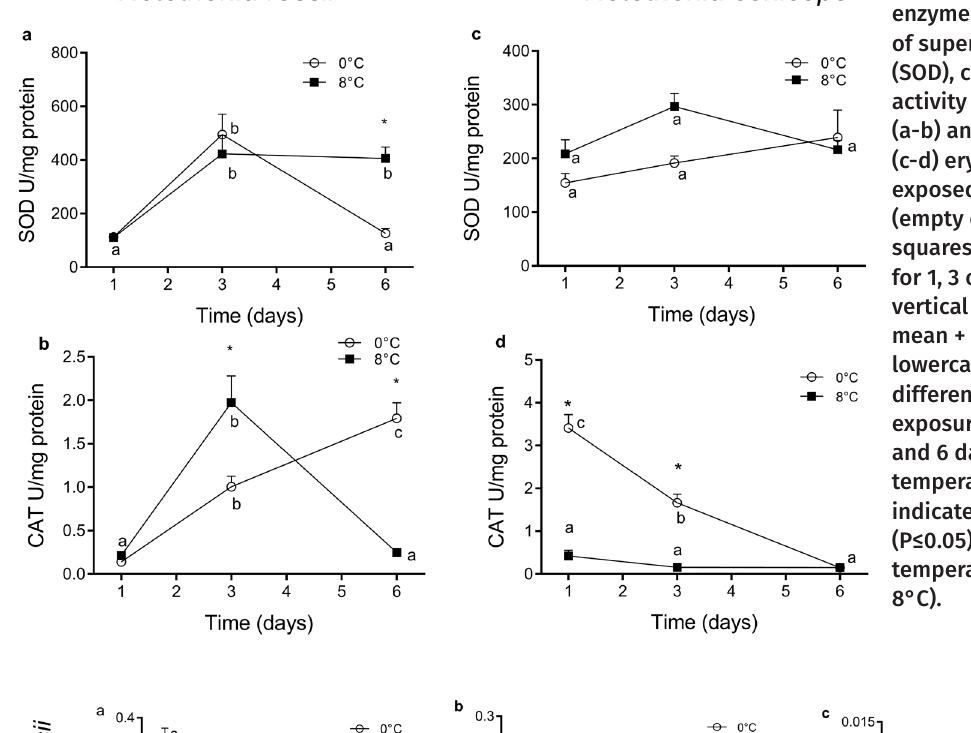
Figure 1. Antioxidant enzyme activity. Levels of superoxide dismutase activity in N. rossii